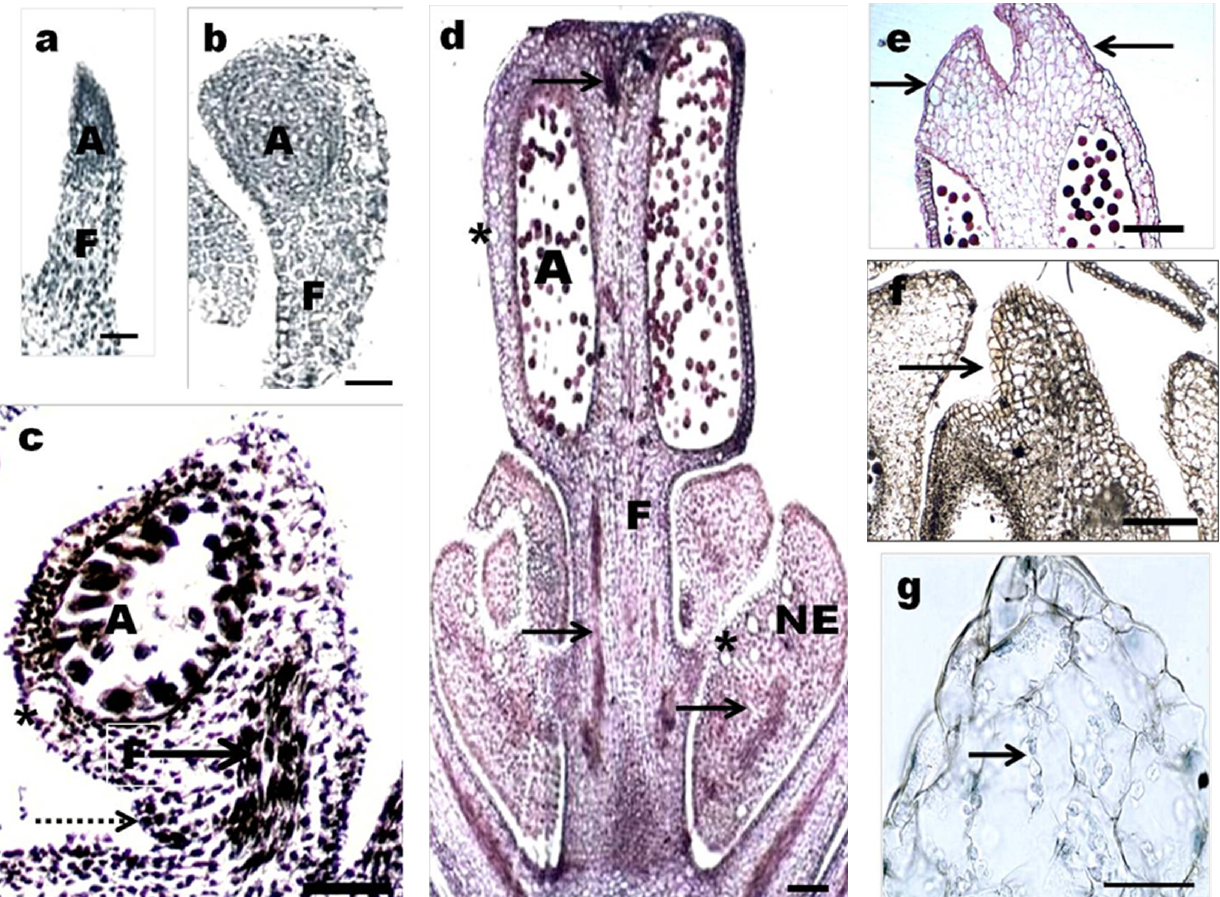
Fig. 4. Stamen development. a-c: Only one of 2 microsporangia is seen in an anther. a. Young stamens primordium with filament and newly differentiated anther stained with Coomassie brilliant blue, Bar 50 μm ; b. The sporogenous cells in anther stained with Coomassie brilliant blue, Bar 50 μm ; c. Expanding microsporangium and filament with vascular bundle (→) and a nectarium, as a small projection on the filament (→), Bar 100 μm ; d. A complete stamen consisting of an anther with 2 microsporangia and filament with vascular bundles (→) and nectarium, stained with PAS, Bar 100 μm ; e, f. Appandages at mature anther, Bar 100 μm ; g. Celllular details of appandage and starch grains (→) stained with Coomassie brilliant blue, Bar 50 μm . A-Anther; F-Filament; NE-Nectarium; Idioblast cells